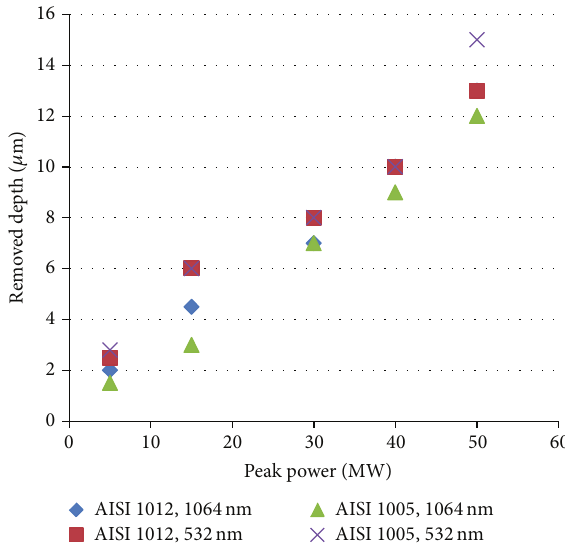
Figure 7: Variation of depth as a function of 𝑃 𝑝 at PRR 4Hz.